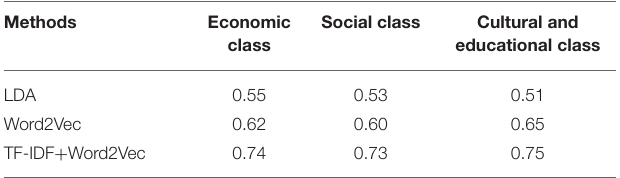
TABLE 1 | The classification results of migrant workers’ concerns based on different methods